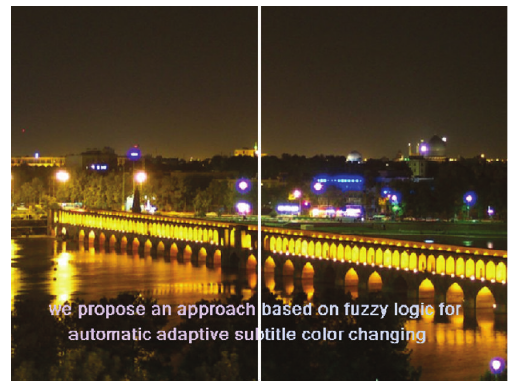
Figure 10: The background image with the centroid values: R = 56, G = 44, and B = 9. (The “si-o-se pol” bridge, Isfahan, Iran). B values of the subtitle color are (Subtitle RED , Subtitle GREEN , and Subtitle BLUE ) = (149, 215, and 196) . The R , G, and B channels of exact opposition color are (126, 134, and 122)